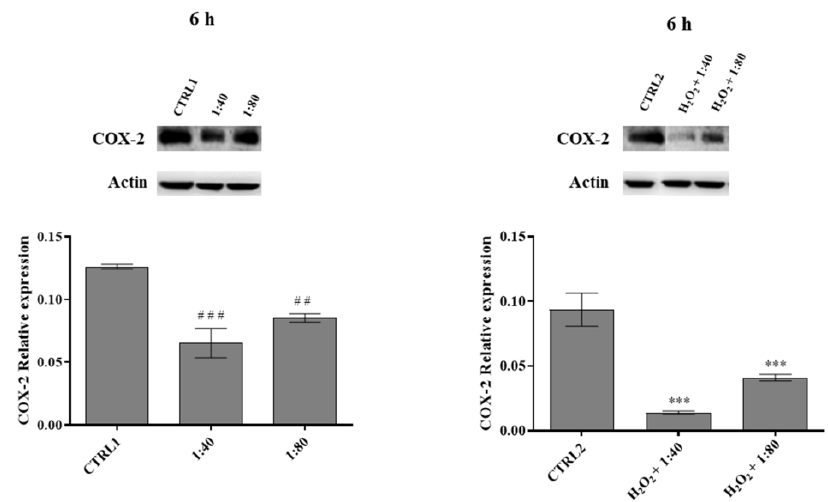
Figure 7. Cyclooxygenase-2 (COX-2) expression levels in HGFs exposed to DMEM culture medium (CTRL1), to SS diluted 1:40 and 1:80 ( left histogram), and of HGFs pre-treated with H 2 O 2 100 µM then exposed to DMEM culture medium (CTRL2) and to SS diluted 1:40 and 1:80 ( right histogram) for 6 h. The most representative of three separate experiments is shown. Actin is used as a loading control. The bar graph displays densitometric values expressed as mean ± standard deviation of COX-2 normalized on loading control. Left histogramvs. CTRL1 ### p < 0.0001, ## p < 0.001; right histogram vs. CTRL2 *** p < 0.0001.